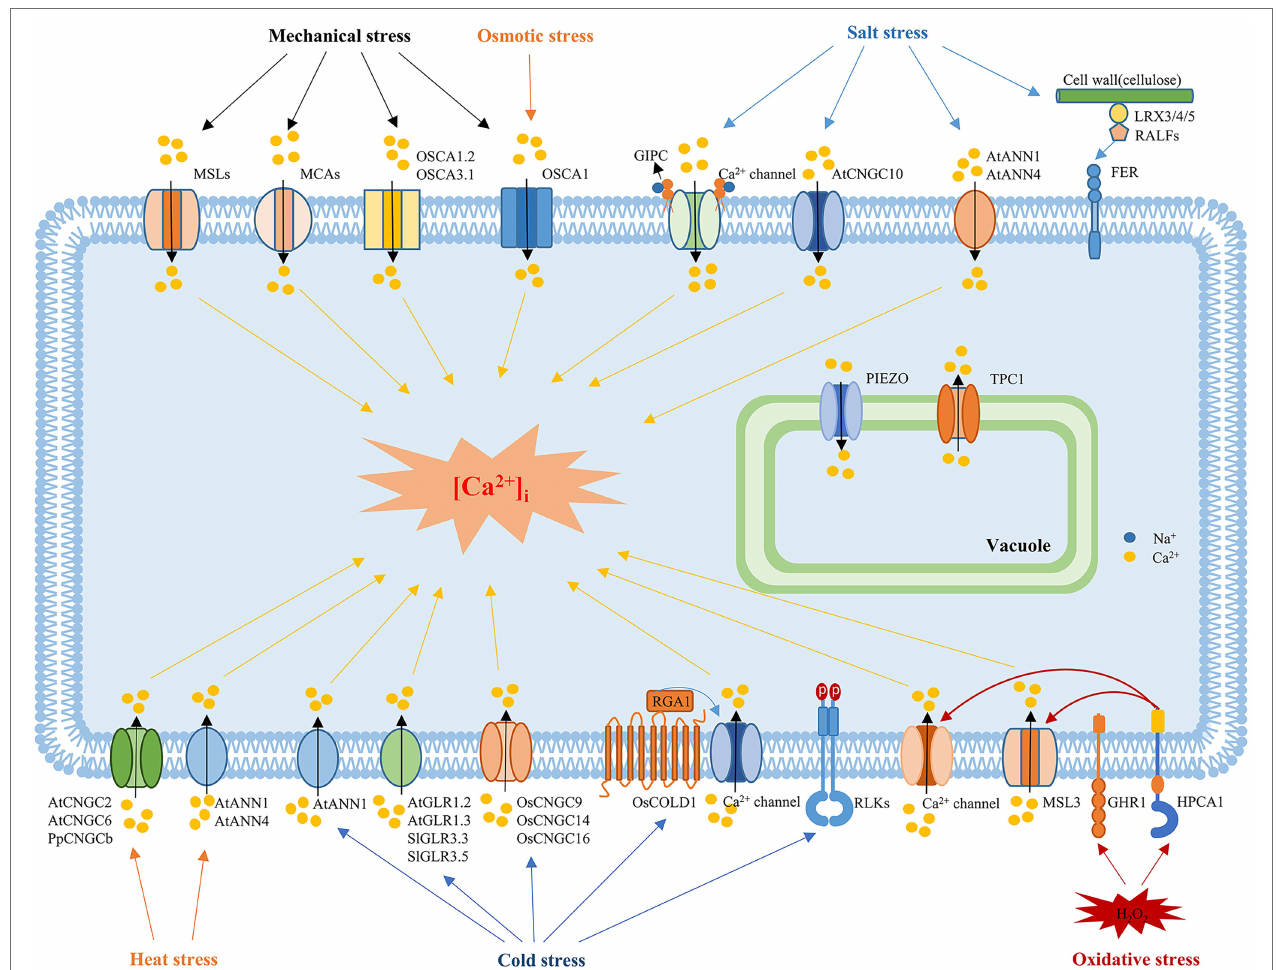
FIGURE 1 | Mechanisms underlying the sensing of abiotic stress in plants. In response to mechanical stimuli, mechanosensitive channels, such as MSLs, MCA, Piezos, and OSCAs, are activated to induce Ca 2+ influx. MCAs and OSCA are plasma membrane mechanosensitive cation channels, while Piezo is located in the vacuole membrane. OSCA1 is a plasma membrane protein that functions as a hyperosmolality-gated calcium-permeable channel that induces the initial increase in [Ca 2+ ] i during osmotic stress. Salt stress is sensed by the binding of monovalent cations to the negatively charged GlcA of the GIPC sphingolipids. Upon Na + binding, the GIPC-gated unknown Ca 2+ channel is activated to trigger the Ca 2+ influx. ANN1, ANN4, and CNGC10 are also involved in the salt-induced Ca 2+ influx. In addition, the cell wall-localized leucine-rich repeat extensins LRX3, LRX4, and LRX5, RALFs and the receptor-like kinase FER also participate in sensing salt stress signals. The vacuolar ion channel TPC1 is involved in systemic salt and Ca 2+ signaling. Environmental stresses trigger tissue-specific and stress-specific [Ca 2+ ] i increases, which are known as “Ca 2+ signatures.” The crucial protein in sensing cold stress in rice is COLD1. COLD1 interacts with RGA1 in response to cold temperatures, resulting in increased GTPase activity, which activates an unknown calcium influx channel. Plasma membrane-localized RLCK plays a negative role in regulating freezing tolerance. In addition, plant CNGCs, such as CNGC9, CNGC14, and CNGC16 in rice, are involved in cold sensing, while CNGC2 and CNGC6 in Arabidopsis and CNGCb in Physcomitrella mediate the heat-induced [Ca 2+ ] i increase. Glutamate receptors, including GLR1.2 and GLR1.3 in Arabidopsis and GLR3.3 and GLR3.5 in tomato plants, also play roles in cold sensing and tolerance. ANN1 and ANN4 are involved in the heat-induced [Ca 2+ ] i increase and tolerance to heat, while ANN1 is also involved in the cold-induced Ca 2+ influx. H 2 O 2 perception causes oxidation of HPCA1, and oxidative modification of HPCA1 might act alone or with a coreceptor to phosphorylate and activate an unknown Ca 2+ channel to trigger Ca 2+ influx. GHR1, a plasma membrane receptor-like kinase, may also sense H 2 O 2 signals and regulate ABA signaling and stomatal closure in guard cells. MSL3 and TPC1 are involved in systemic ROS and Ca 2+